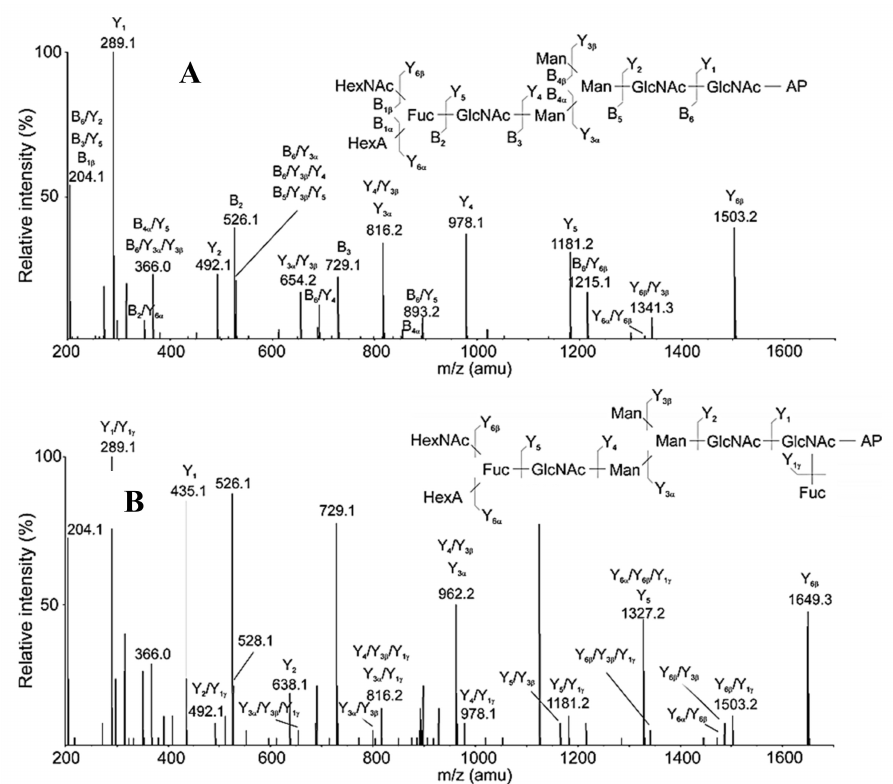
Figure 8. ( A ). MS / MS analysis of 3-AP-glycan from RvH with m / z 853.7 [M + 2H] 2 + eluted at 14.87 min. ( B ) MS / MS analysis of 3-AP-glycan from RvH with m / z 926.8 [M + 2H] 2 + , eluting at 14.87